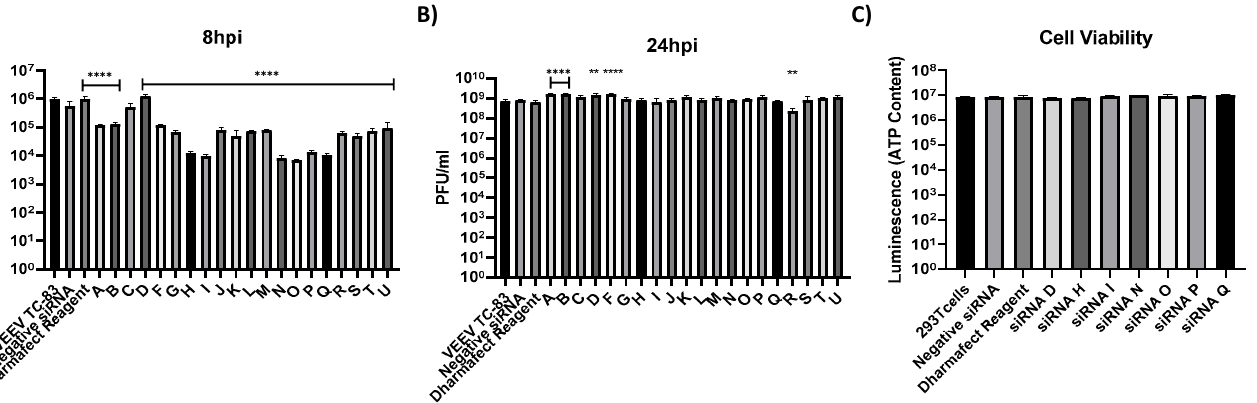
Figure 1. Anti-VEEV siRNAs can cause reduction in VEEV TC-83 replication. ( A , B ) 293T cells were transfected with 20 nM individual VEEV specific siRNAs 24 h prior to infection. Transfected cells were then infected with VEEV TrD at an MOI of 0.1 and supernatants were collected at 8 hpi ( A ) and 24 hpi ( B ). Viral titers were determined via plaque assay. ( C ) Cytotoxicity of siRNA was determined in 293T cells using CellTiter-Glo Luminescent Cell Viability Assay 24 h post transfection. Negative siRNA is nonspecific to VEEV and human genome. Graphs represent data from two independent experiments performed in triplicates ( n = 6). ** p < 0.0021, **** p < 0.0001 compared to negative control siRNA.